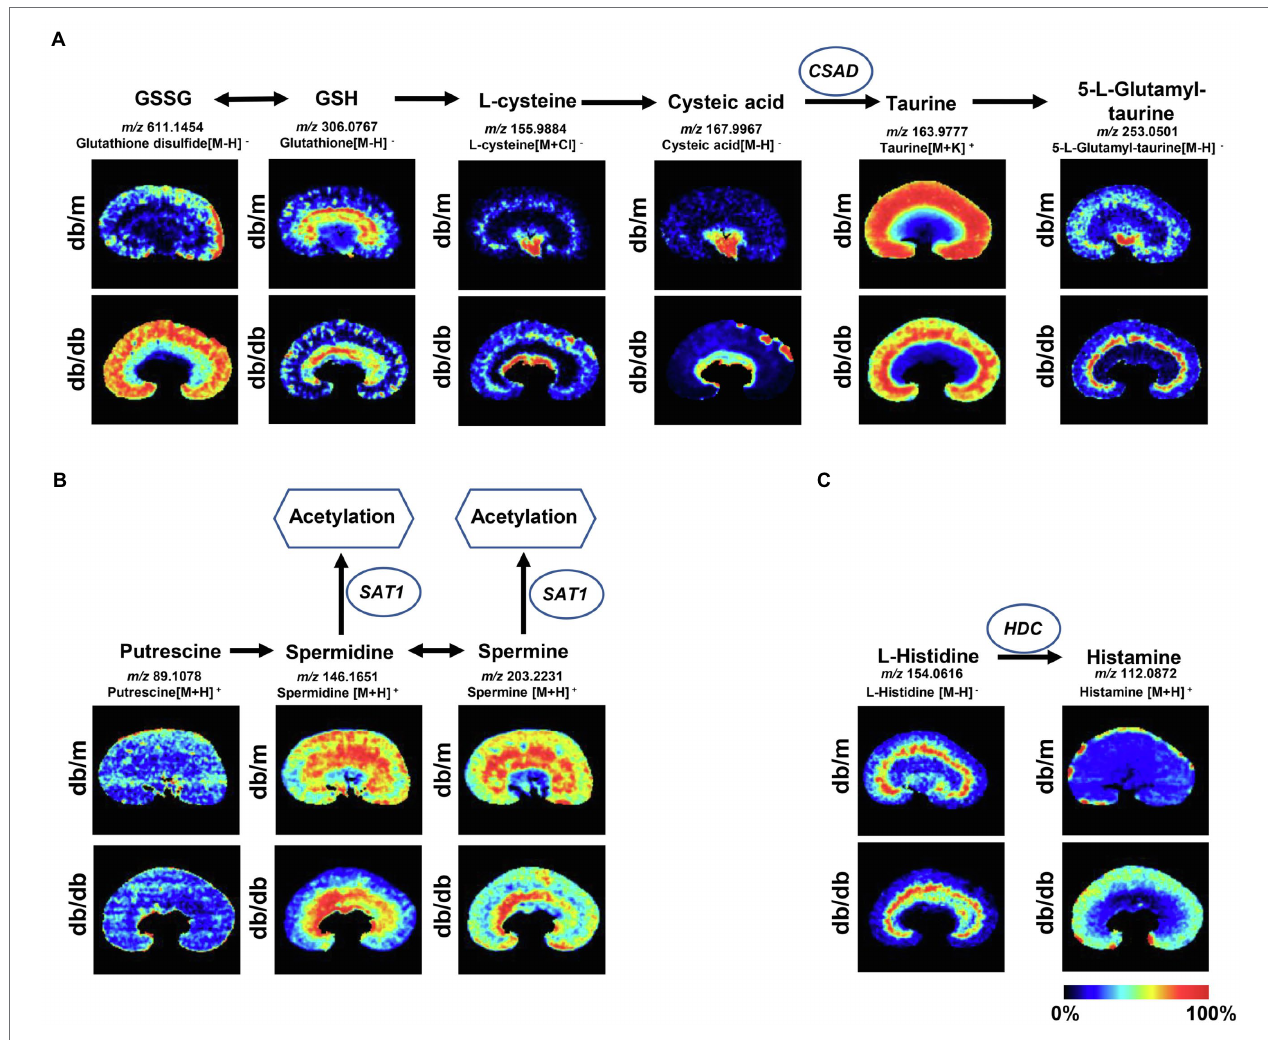
FIGURE 4 | Mass spectrometry images of discriminating metabolites involved in the disturbance of metabolic pathways associated with DKD. Spatial distribution and changes of metabolites involved in (A) taurine and hypotaurine metabolic pathway, (B) arginine and proline metabolism, and (C) histidine metabolic pathway. The blue ellipses represent rate-limiting enzyme that regulate specific metabolic pathways. GSSG, Glutathione disulfide; GSH, glutathione; CSAD, sulfinoalanine decarboxylase; HDC, histidine decarboxylase; and SAT1, spermidine/spermine N1-acetyl transferase